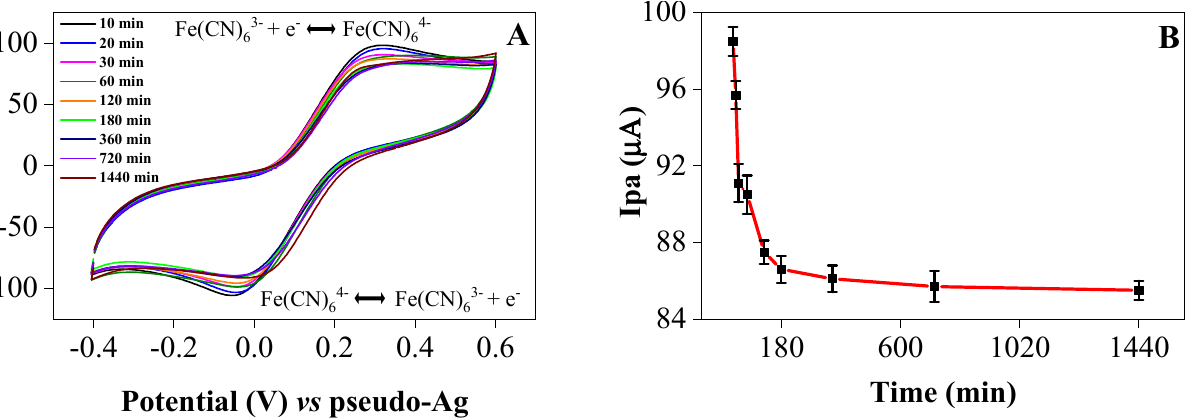
Figure 3. Stability of the immunosensor through cyclic voltammetry in 5 mmol L − 1 [Fe(CN)6] 3 − /4 − + 0.1 mol L − 1 KCl. 3.2. Cyclic Voltammetric and Chronoamperometric Studies of TMB at SPCEs CV was used to investigate the oxidation and reduction process of the TMB on a SPCE, by scanning the potential between − 400 and 600 mV at a scan rate of 50 mV s − 1 . Figure 4 shows the cyclic voltammograms obtained for bare SPCE and CG/SPCE.